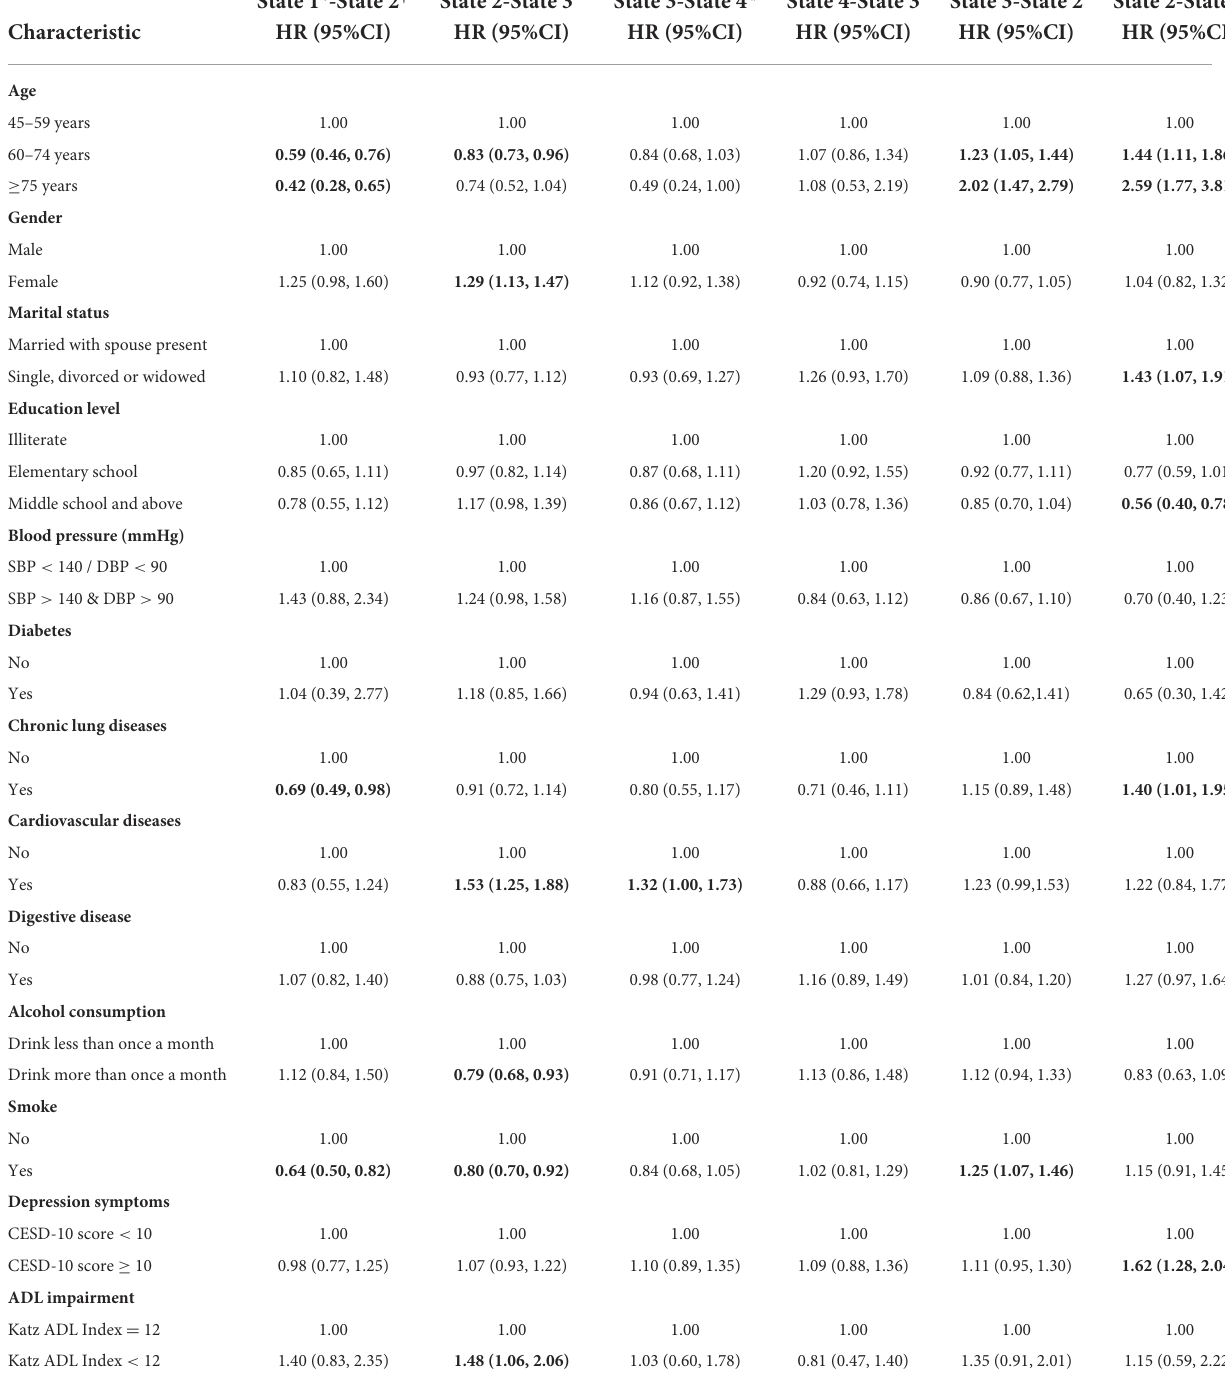
TABLE 4 Estimated hazard ratios of each exposure factor effect on the BMI transition intensities by multi-state